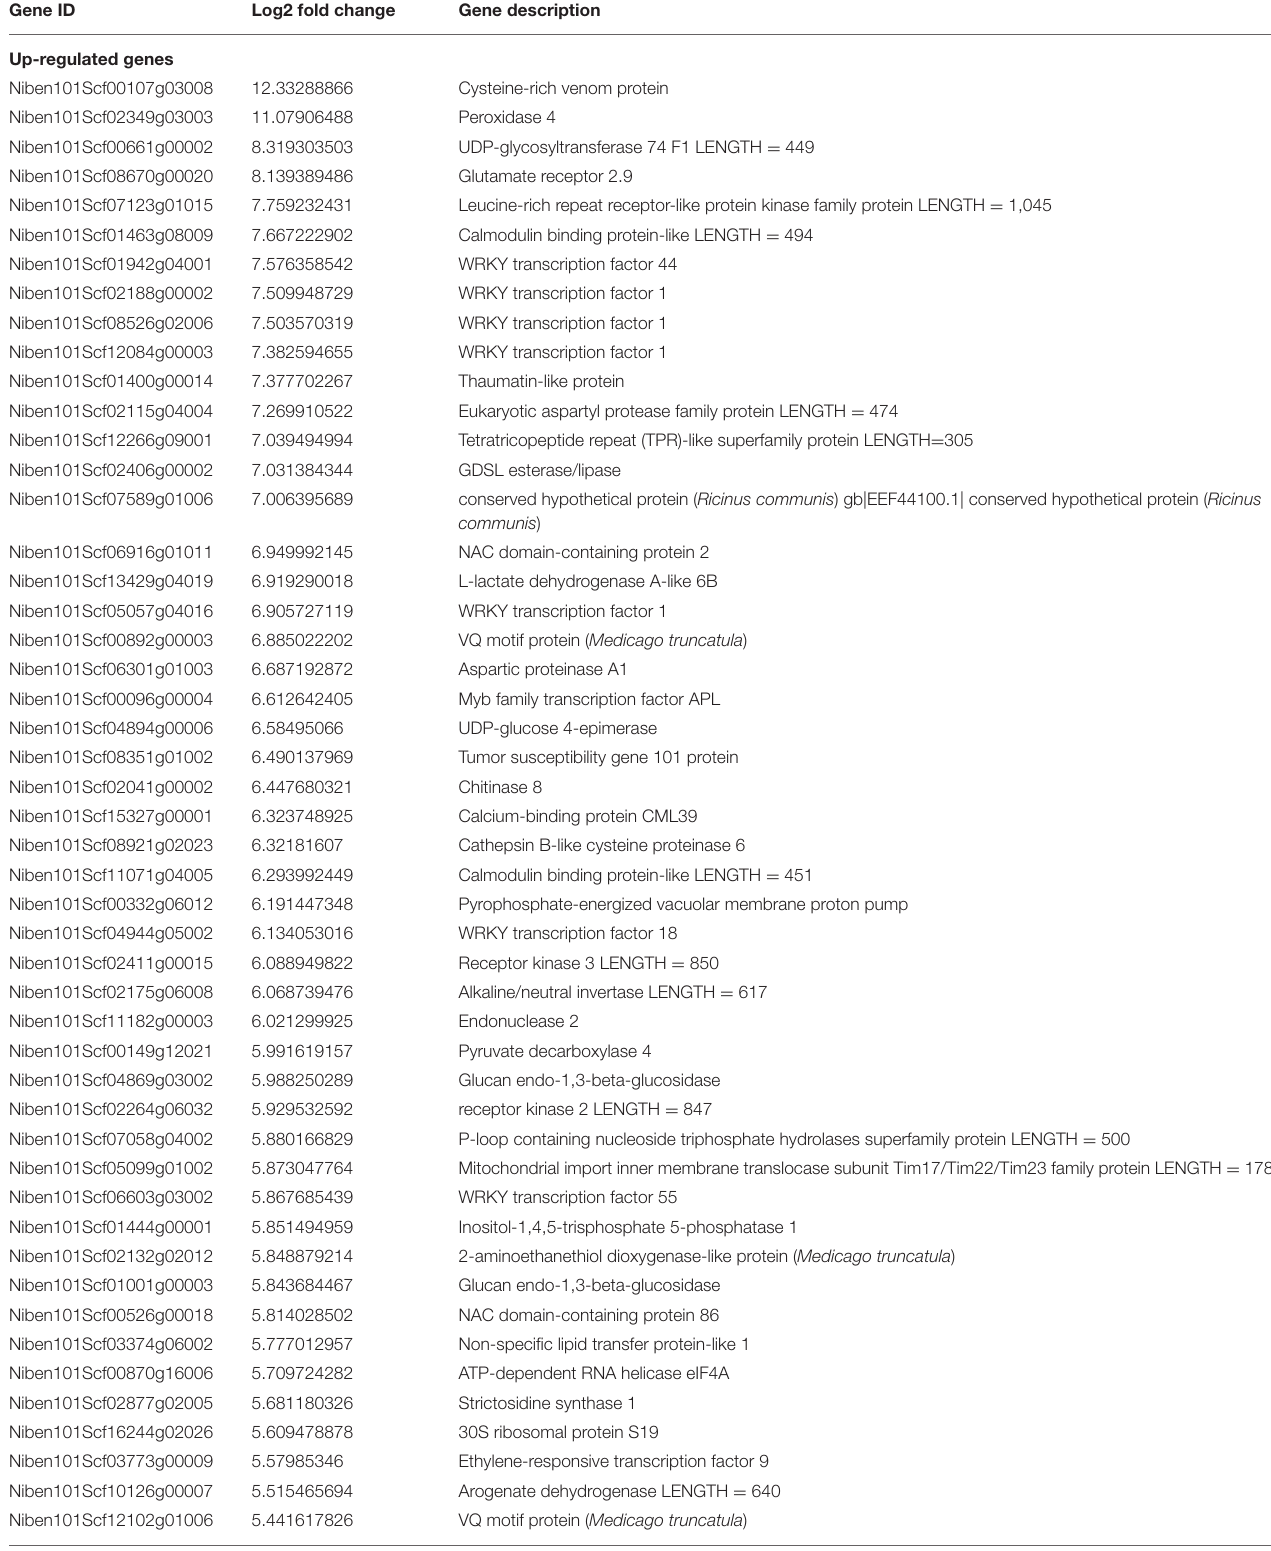
TABLE 1 | Most important differentially expressed genes in tobacco plants inoculated with TOR3209. Gene ID Log2 fold change Gene